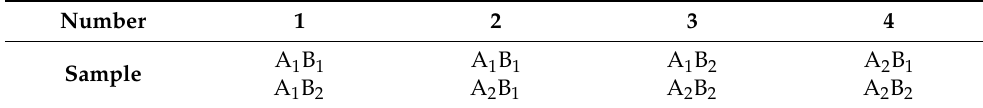
A 2 B 1 A 2 B 2